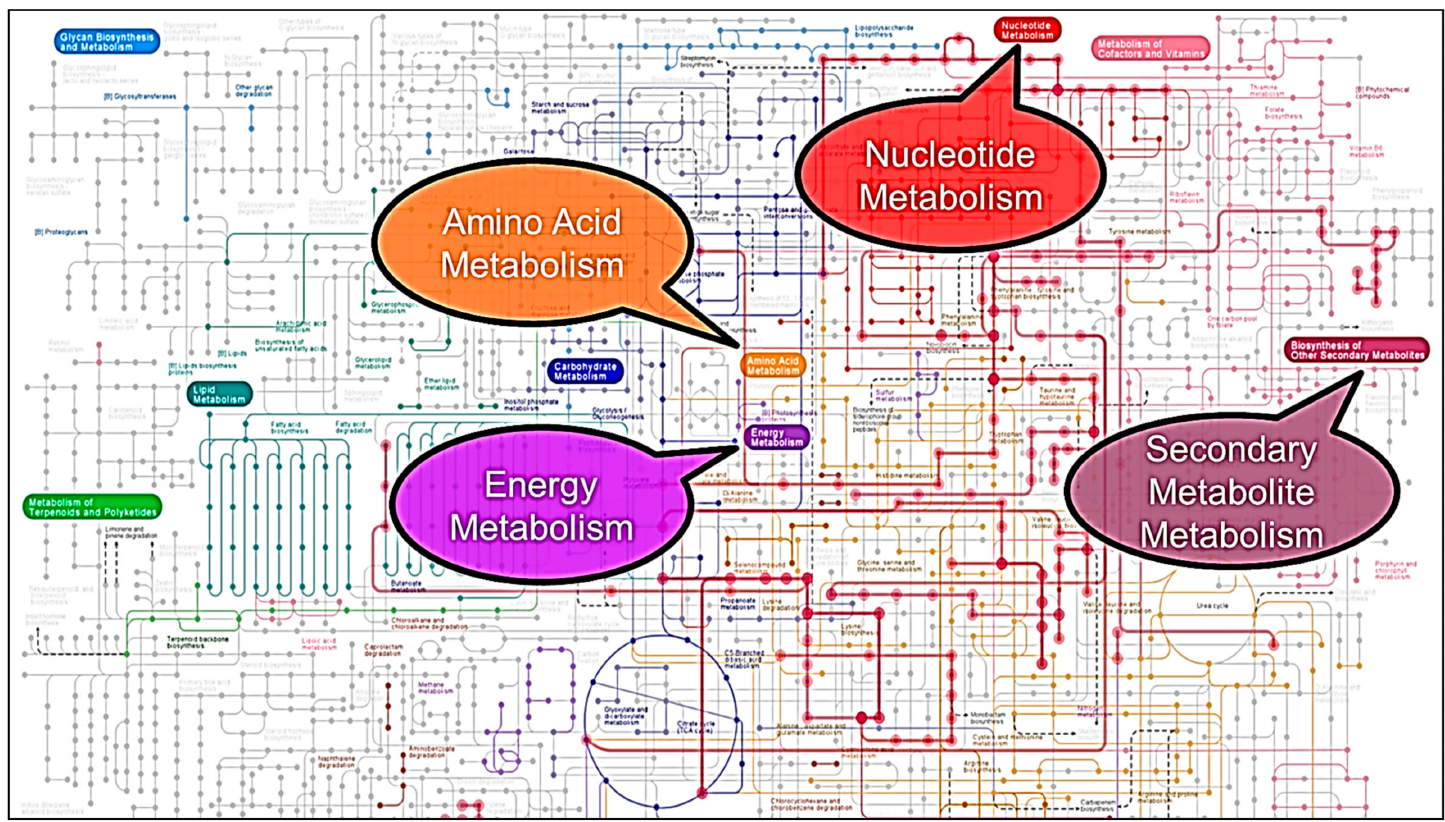
Figure 8. Overview of KEGG-based metabolic network derived from all detectable compounds extracted from